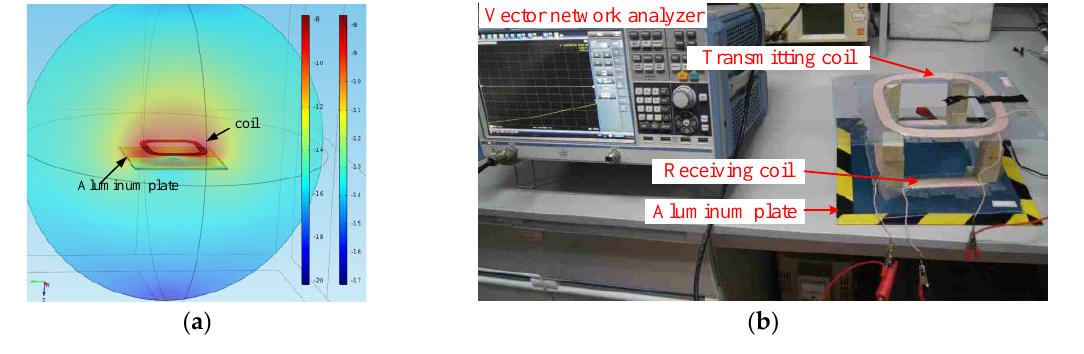
Figure 5. ( a ) Simulation model; ( b ) Experiment model.